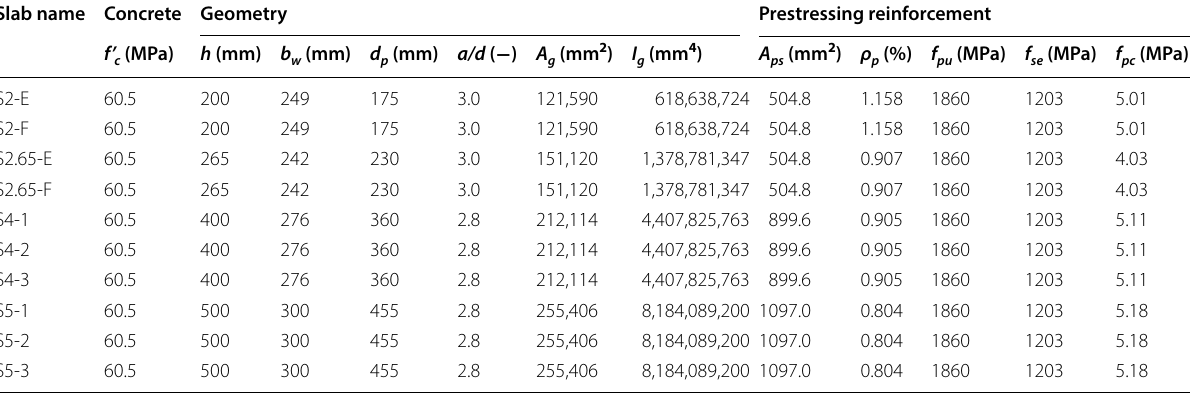
Table 2 Material and dimesional properties of test